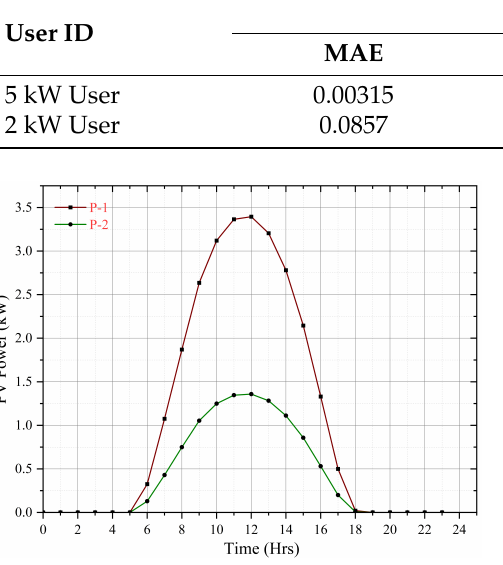
Figure 2. Prosumer PV power generation